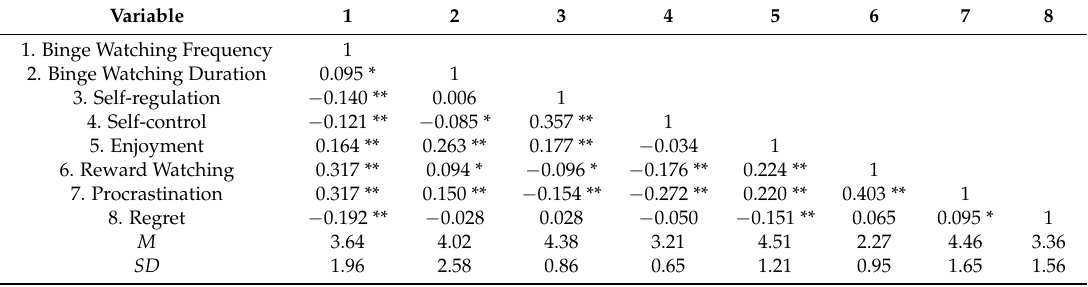
Table 2. Summary of correlations between variables ( N =